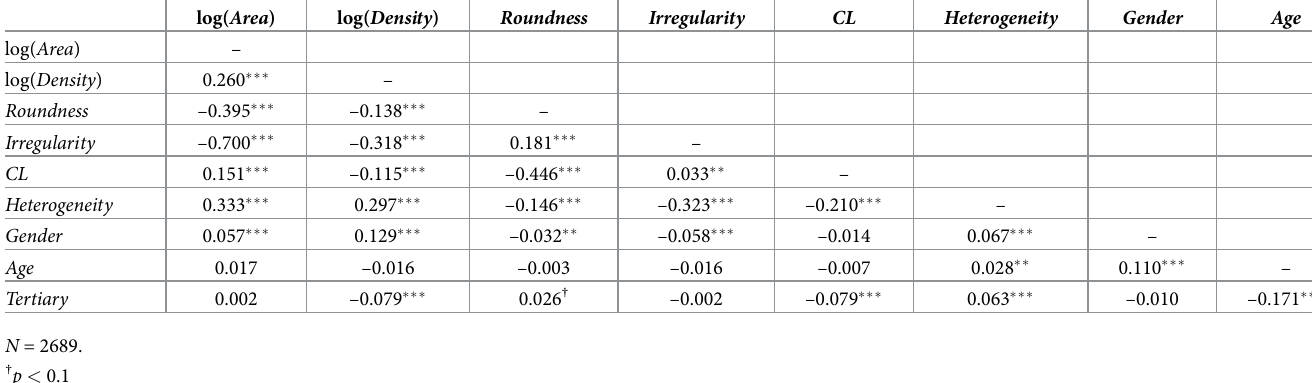
Table 4. Kendall rank correlation coefficient between the independent variables for the clusters with at least ten cells observed in 2005.